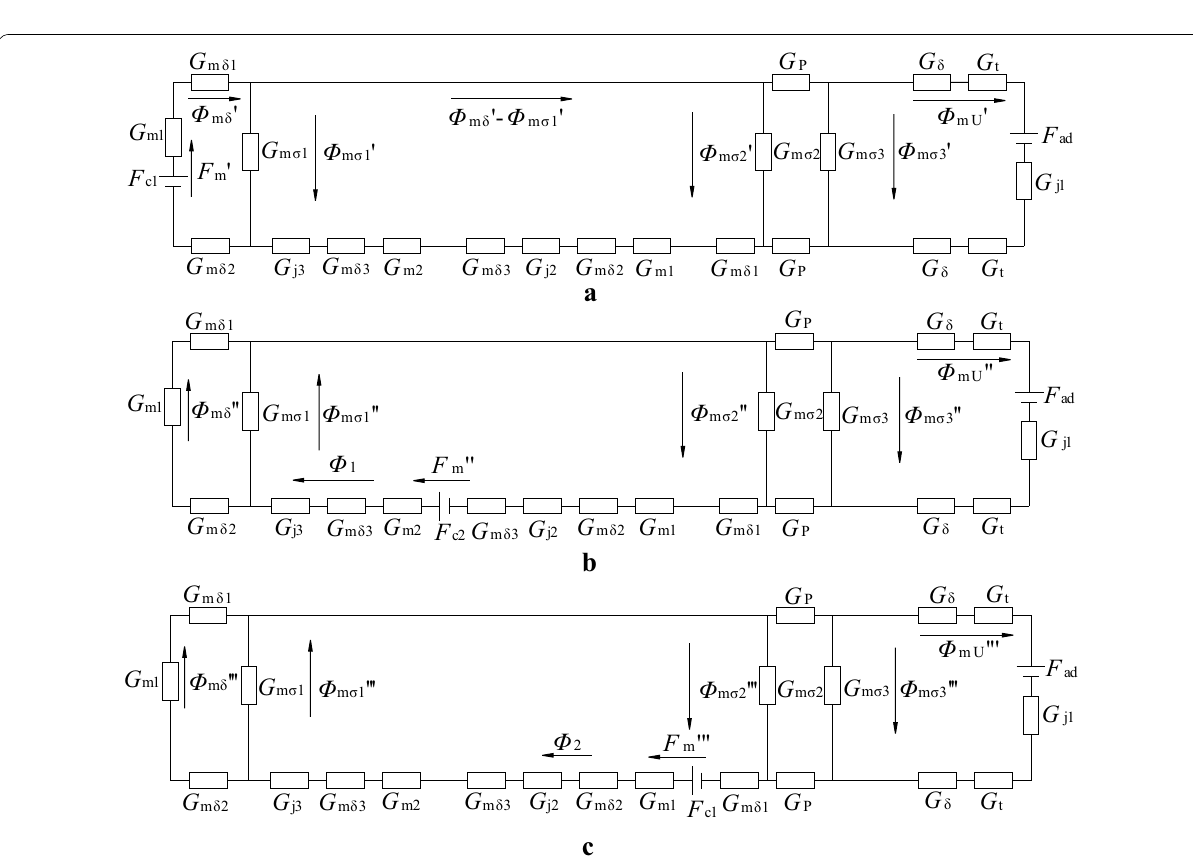
Figure 11 Superposition principle diagram of permanent magnet part equivalent magnetic circuit model. a Model a of permanent magnet part equivalent magnetic circuit. b Model b of permanent magnet part equivalent magnetic circuit. c Model c of permanent magnet part equivalent magnetic